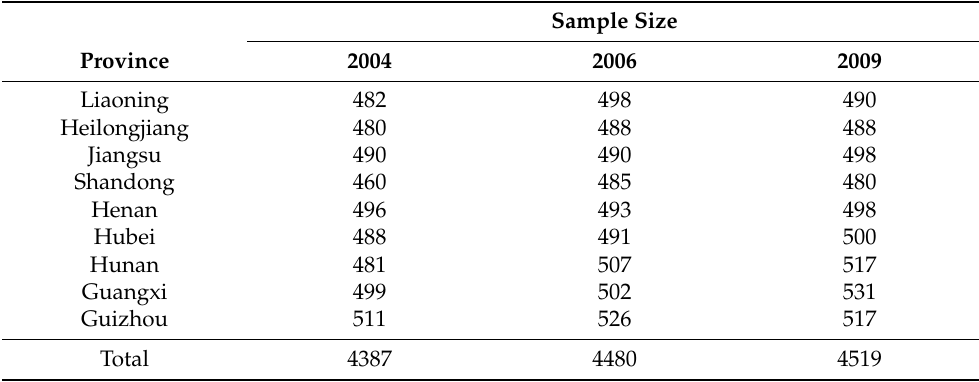
Table 1. Sample size used in this